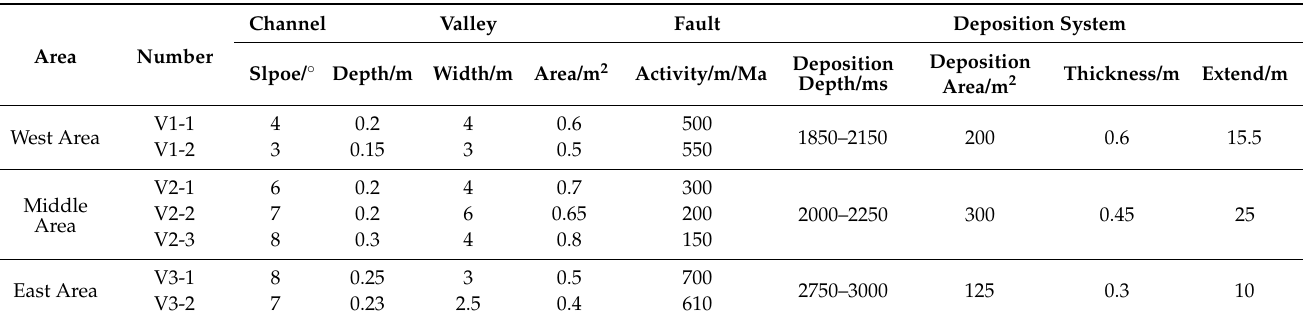
Table 1. The channel information of the west, middle, and east areas in the northern steep-slope zone of the Weixinan